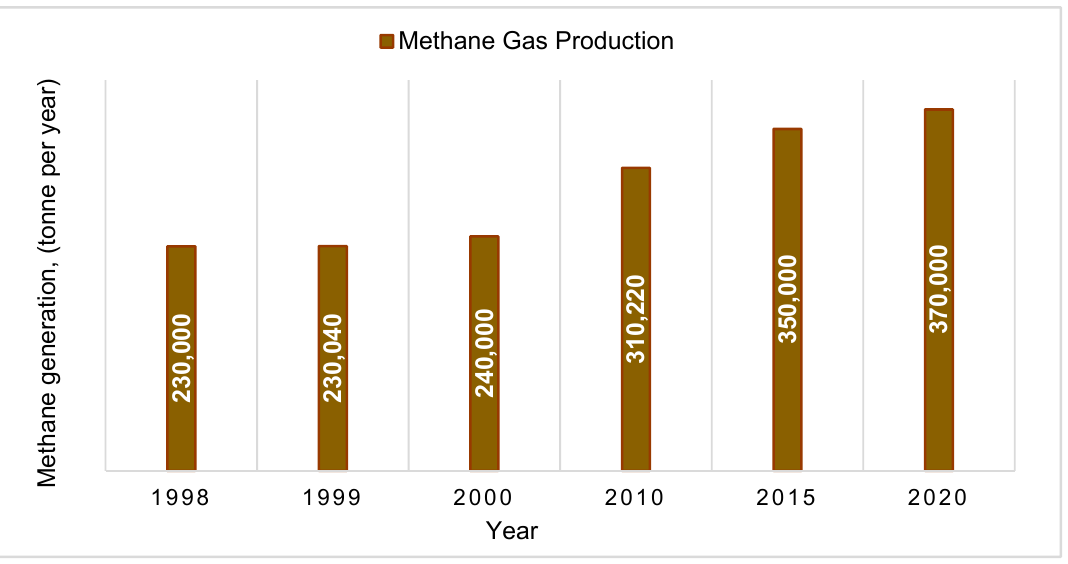
Figure 9. The generation of methane gas from 1998 to 2015 and the predicted value for 2020 [33].